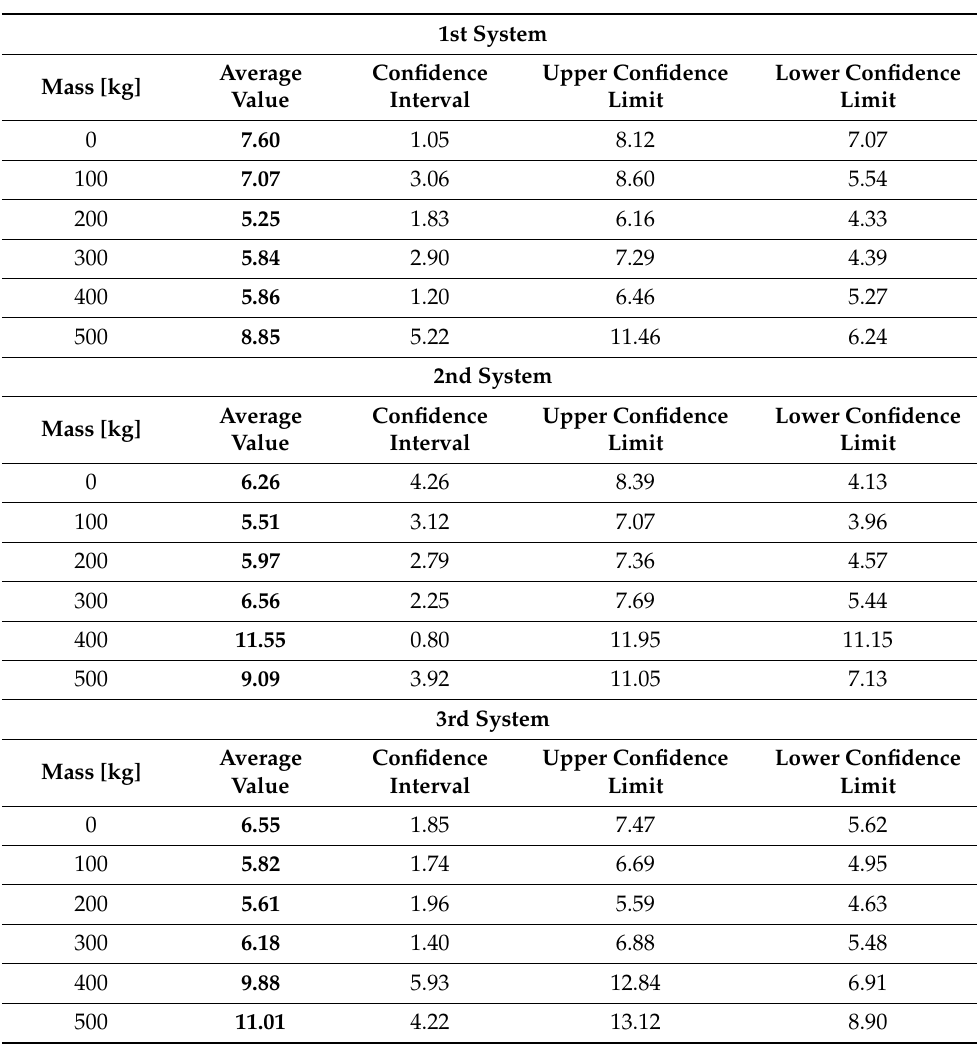
Table 3. Results of the statistical analysis for the T Student distribution in the 95% confidence interval, in